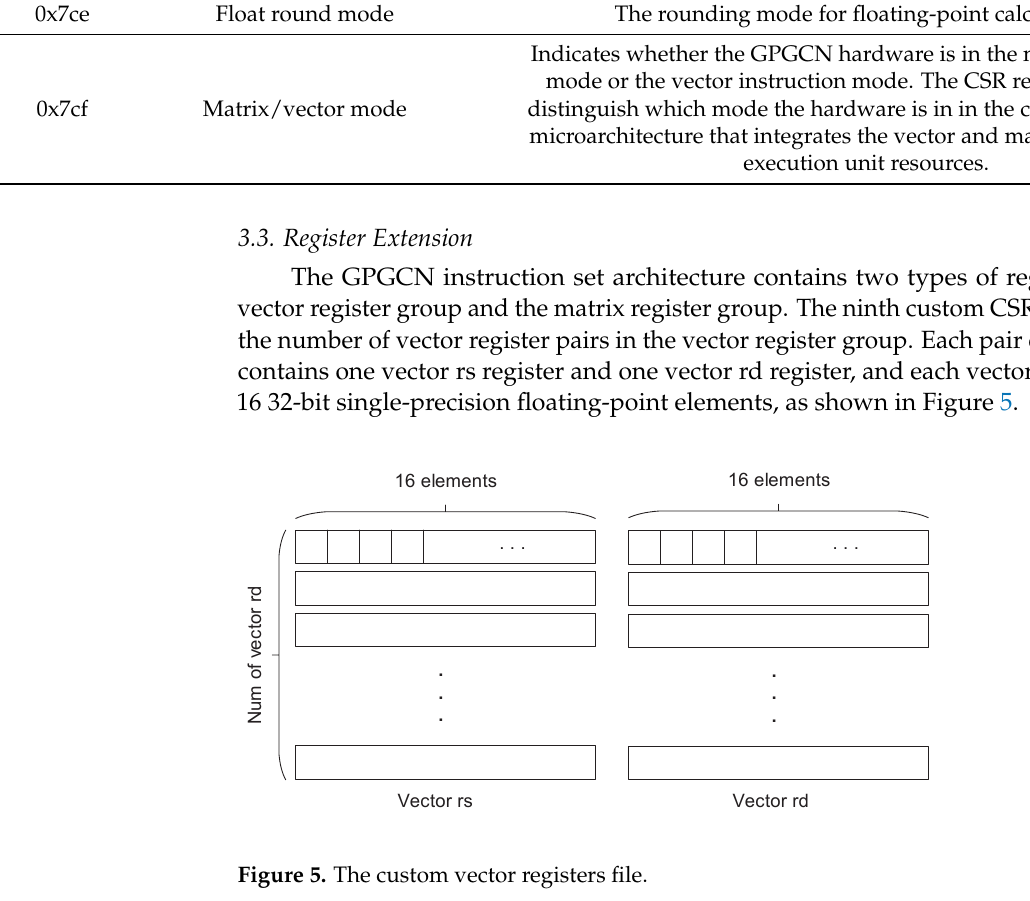
Figure 5. The custom vector registers file.